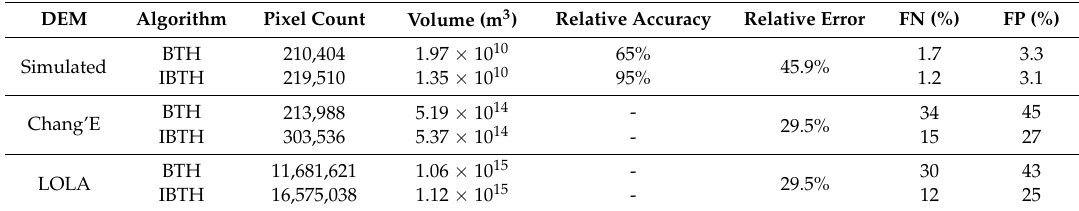
Table 1. Comparison of volume estimate by BTH and IBTH